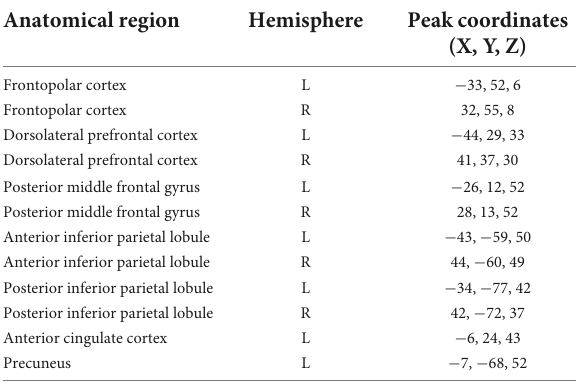
TABLE 2 fMRI regions showing functional activation during the N-back tasks. Anatomical